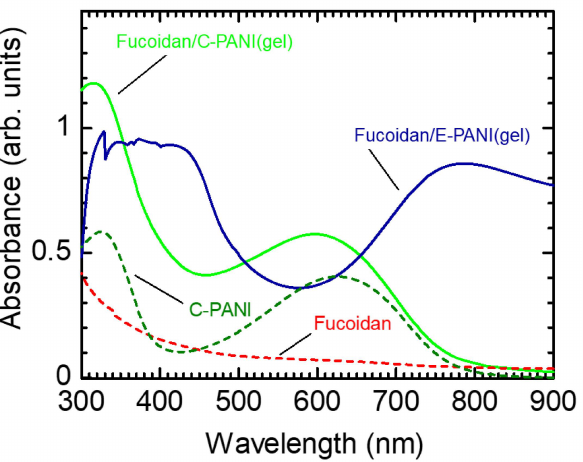
Figure 12. Optical absorption spectra of the pure fucoidan, C-PANI, fucoidan/C-PANI(gel), and fucoidan/E-PANI(gel).